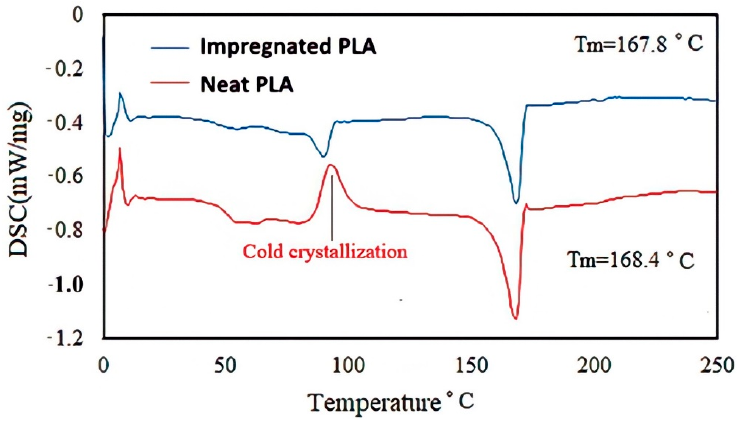
Figure 8. DSC analyses results of the neat PLA and PLA impregnated at the optimum conditions.